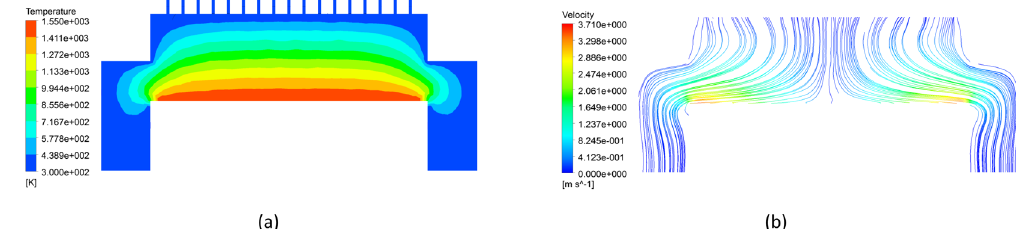
Figure 4. Distributions of fields ( a ) temperature and ( b ) velocity magnitude in the reactor.